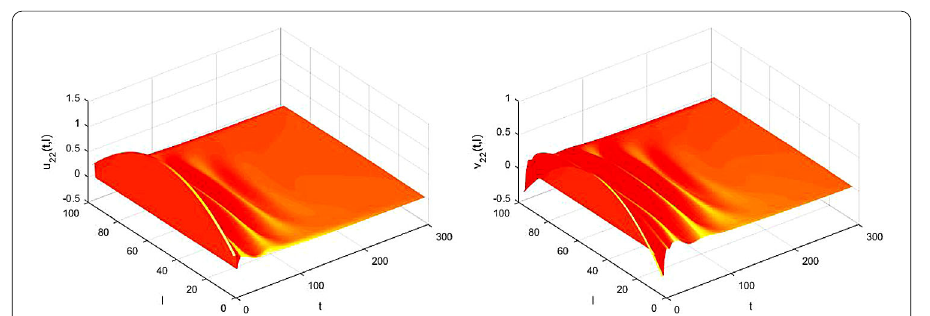
Figure 7 The trajectory of u 22 ( t , l ) and v 22 ( t , l